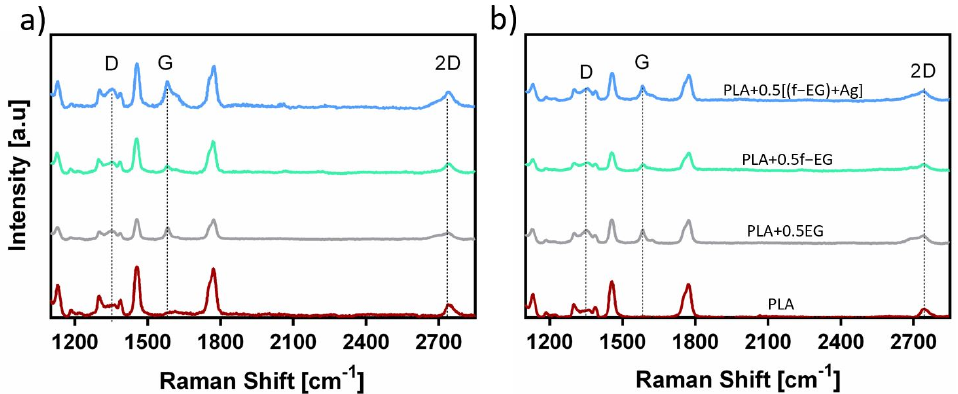
Figure 12. Raman spectra obtained for ( a ) Fil3D and ( b ) FilText with 0.5wt.% of EG, f-EG, and [(f- EG)+Ag].